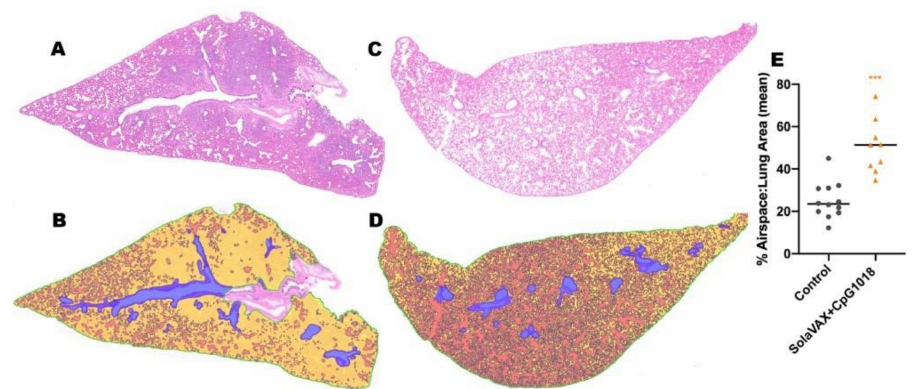
Figure 5. Airspace histology analysis for unvaccinated and vaccinated hamsters (SolaVAX + CpG1018 adjuvant) at day 7 post-challenge. ( A ) Representative lung histology from an unvaccinated control and ( B ) respective airspace analysis. ( C ) Representative lung histology from SolaVAX + CpG1018 vaccinated hamster and ( D ) respective airspace analysis. Quantified airspace is labeled in orange and solid tissue in yellow. Large airways and vessels are excluded from analysis (blue). ( E ) Percent airspace quantified as a ratio to total lung area excluding airways and vessels. Each point represents the percent airspace quantified for a single lung